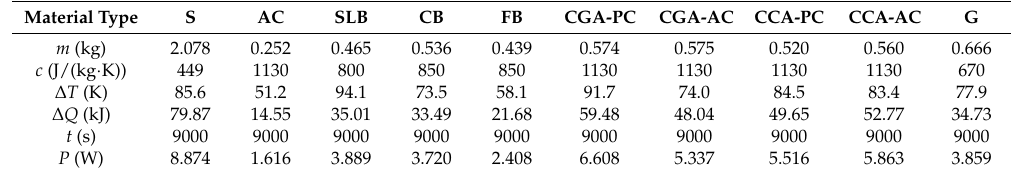
Table 7. The thermal power of the materials tested—the first stage of the